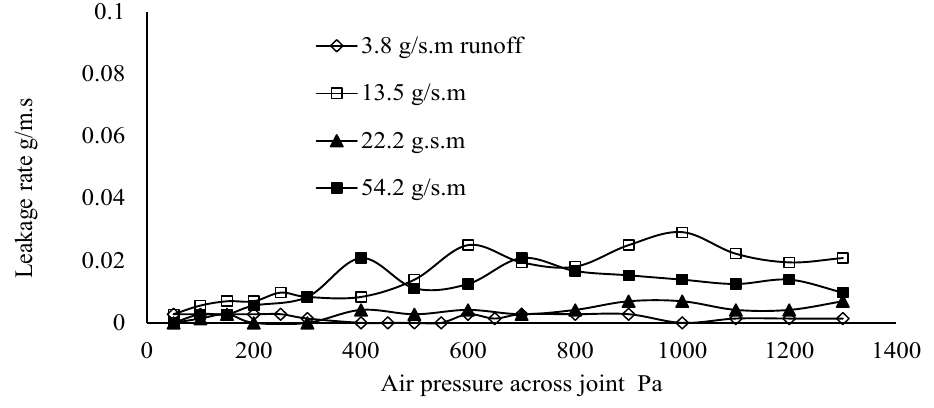
Figure 16. Water leakage rates through the cavity closer above a saddle